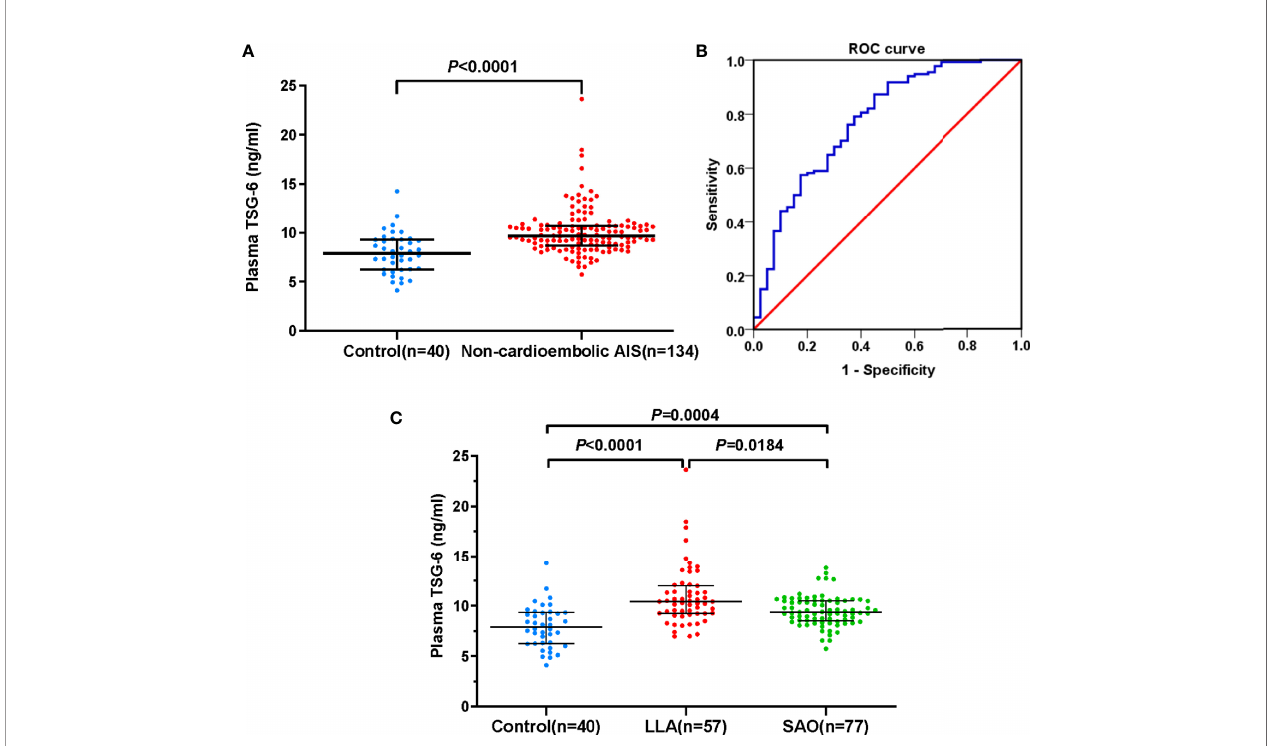
FIGURE 2 | Plasma TSG-6 levels. (A) Control subjects and non-cardioembolic AIS. (B) The ROC curve of plasma TSG-6 concentration for detecting non-cardioembolic AIS. The AUC value is 0.774 (95% CI, 0.686 – 0.861; P < 0.0001). (C) Control subjects, LLA, and SAO AIS. Horizontal lines represent median levels and interquartile ranges. P -values determined by the Mann – Whitney U test (A) and Kruskal – Wallis test (C) . AIS, acute ischemic stroke; TSG-6, tumor necrosis factor-stimulated gene-6; LLA, large-artery atherosclerosis; SAO, small-artery occlusion; ROC, receiver-operating characteristic; AUC, area under the